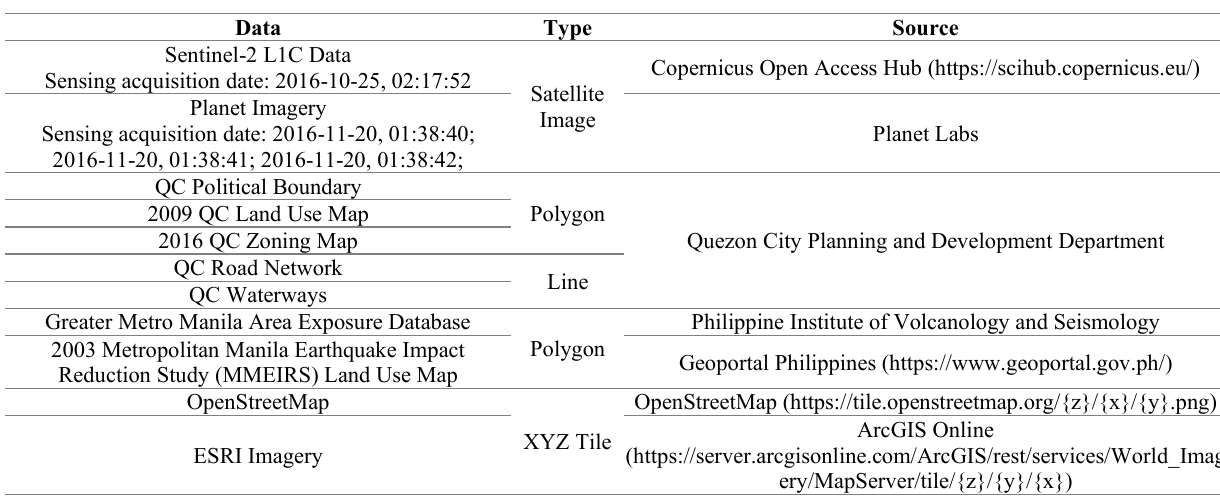
Table 2: Data acquired and used in mapping residential land use of different densities in Quezon City, Philippines